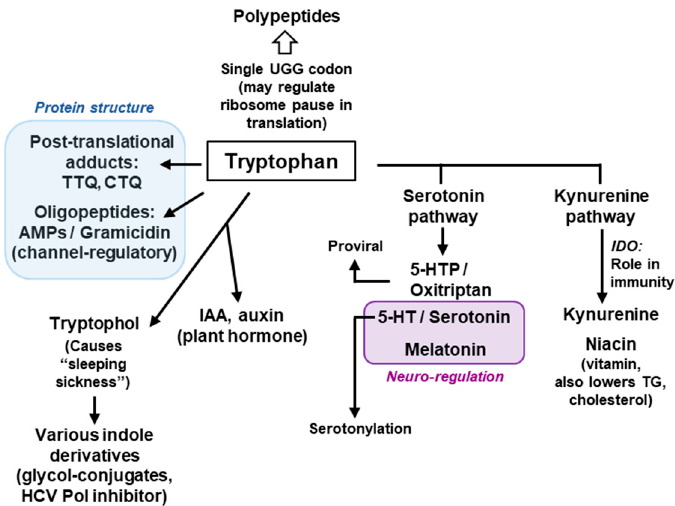
Figure 9. Brief schematic summary of the major roles of Trp. This is a concise diagram, showing only a few selected contributions of Trp, its metabolic products and their major roles and common usage. All compounds and their abbreviated names have been described at appropriate places in the review. The two-colored boxes indicate the main functions of the boxed Trp products, namely, the role in protein structure (Blue) and neuro-regulation (Brown). HCV = Hepatitis C virus. Note that this is by no means an exhaustive list and that many compounds have multiple roles, and many roles are played by multiple compounds, which are not shown here for the sake of brevity. AMP = Antimicrobial